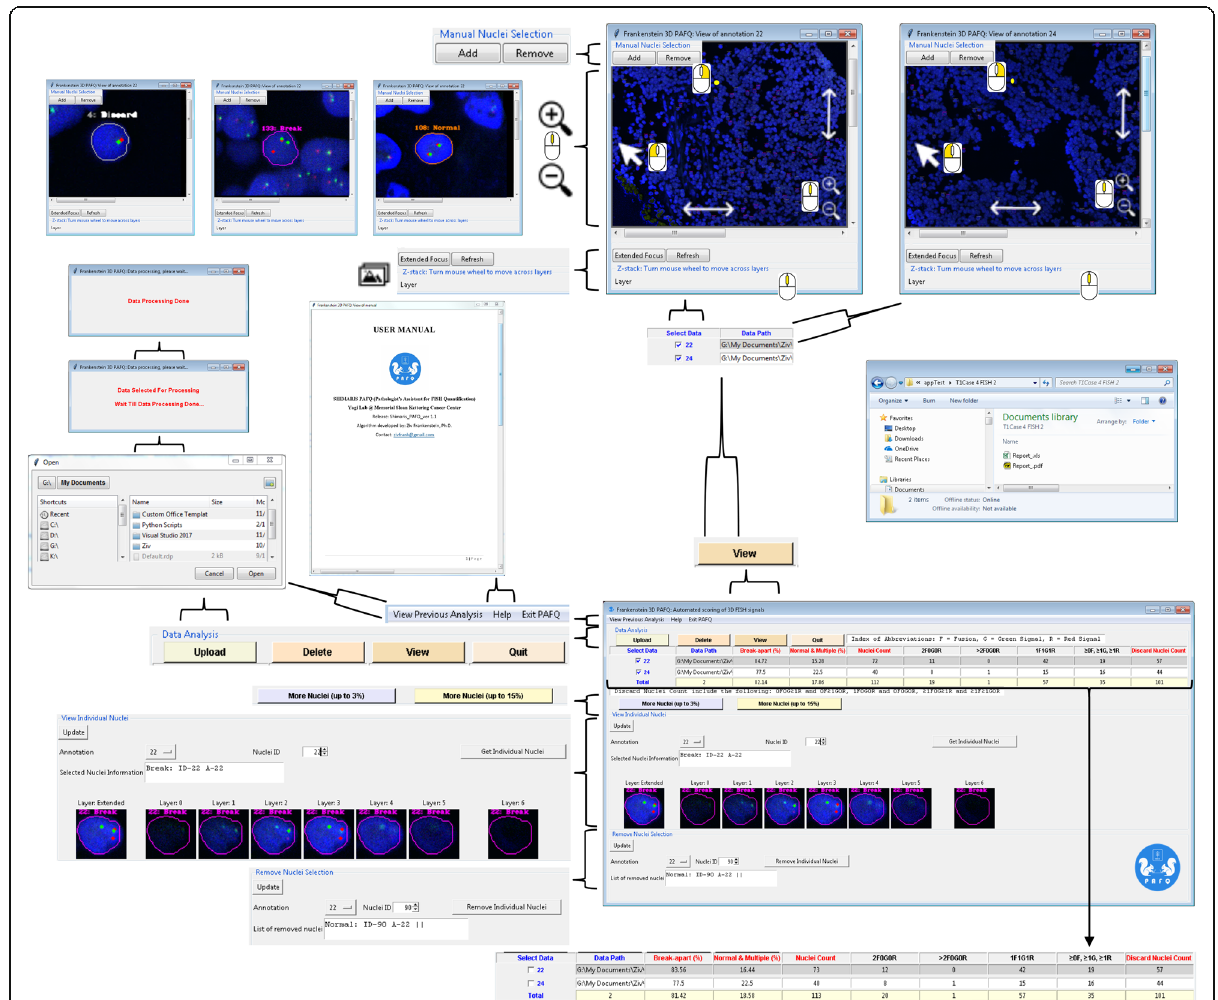
Fig. 4 Application description for 3D scoring of FISH using confocal WSI scanner. Flowchart showing application functions, such as 3D data uploading, 3D data deletion, viewing of counting and scoring results, selecting and removing an individual nuclei from the calculations, z-stack image zooms and translations view, export and view of clinical report, quit the software, as well as assistance through manual